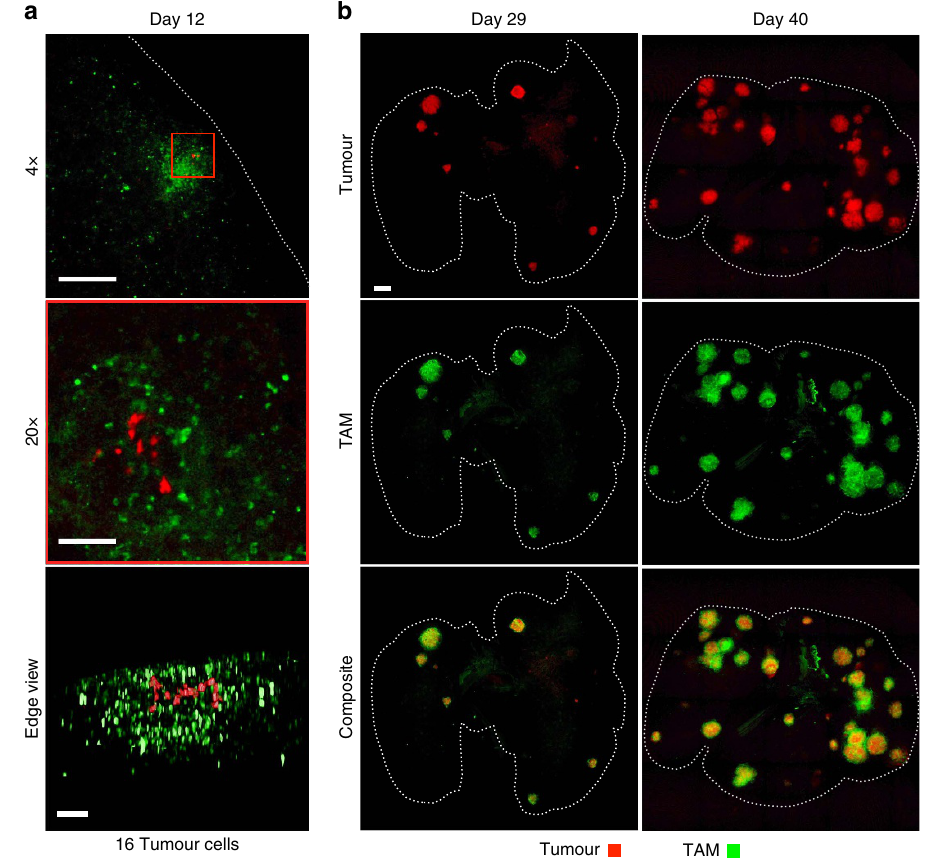
Figure 2 | Detection and analysis of whole lung tumour burden. ( a ) Identification of TAM presence surrounding early-stage tumours. TAM infiltration is observed in response to 16 individual tumour cells within a single nascent nodule. Scale bars, 1,000 m m (top); 100 m m (middle/bottom). ( b ) Analysis of tumours in mice at two stages of disease progression revealing facile detection of tumours and a heterogeneous distribution of TAM and tumour location. Dashed lines outline the lung. Scale bars, 1,000 m m. For all, days denote time post inoculation.